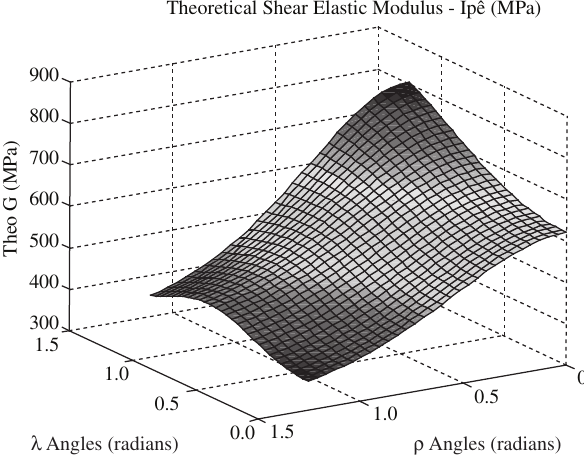
Figure 9. Three -Dimension diagram of Elastic Modulus and Euler’s angles for Ipê.